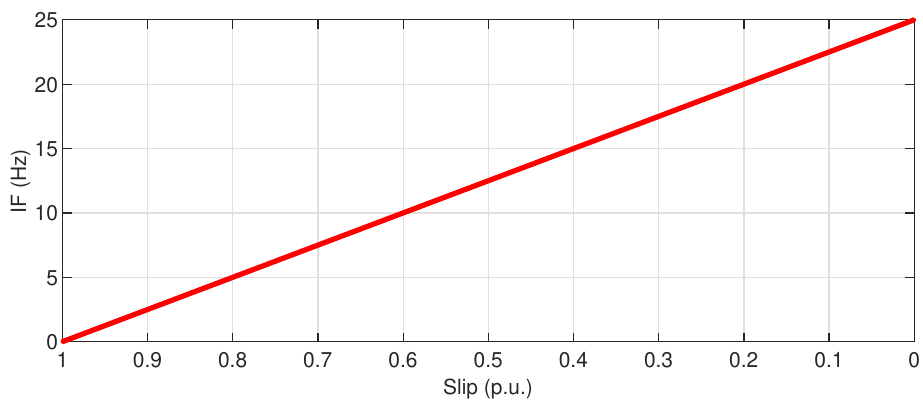
Figure 16. Theoretical evolution of the IF of the mixed eccentricity fault components in the envelope of the start-up